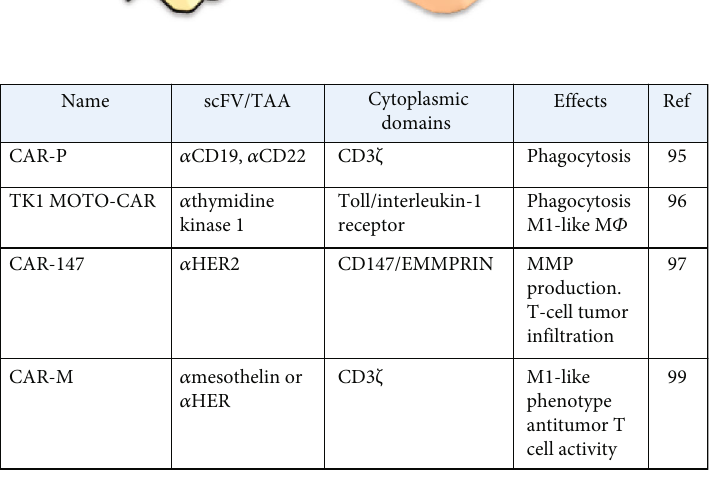
Figure 3: Adoptive cell therapy and macrophage. (a) Primary chimeric antigen receptor (CAR) features are exposed. scFv: single-chain antibody variable fragment; TM: transmembrane domain. The bottom fi gure indicates the treatment with the fourth-generation CAR T- cell strategy. After engagement to tumor-associated antigen (TAA), CAR T-cells are activated and may exert antitumor activities by releasing cytotoxic molecules. Furthermore, CAR activation promotes the expression and secretion of IL-12 or IL-18 that may induce TAM shift to tumoricidal functions. (b) TAMs engineered with CAR new strategies implicate the CAR-modi fi ed macrophages. The table indicates CAR-modi fi ed macrophages, speci fi c targets, intracellular CAR domains, and the main functional activities promoted by CAR macrophage